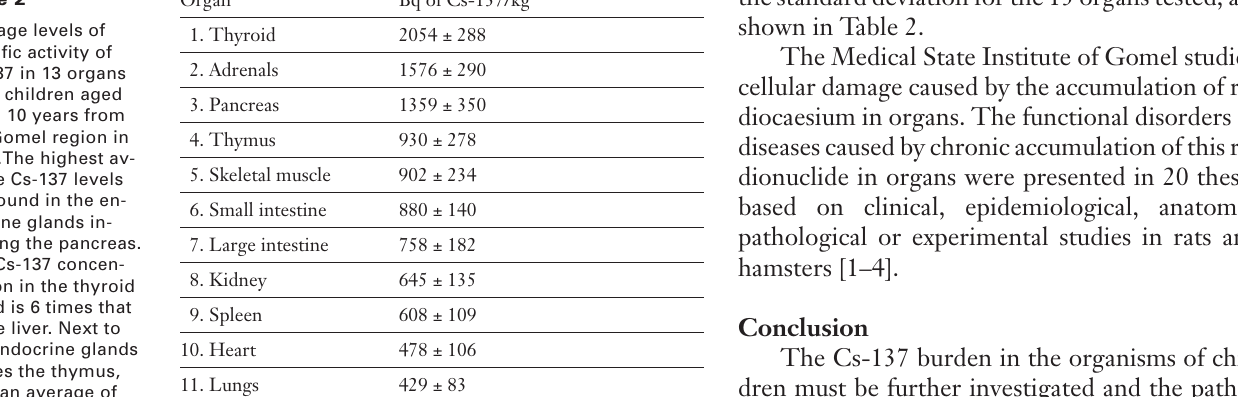
Average levels of specific activity of Cs-137 in 13 organs of 52 children aged up to 10 years from the Gomel region in 1997.The highest av- erage Cs-137 levels are found in the en- docrine glands in- cluding the pancreas. The Cs-137 concen- tration in the thyroid gland is 6 times that in the liver. Next to the endocrine glands comes the thymus, with an average of 930